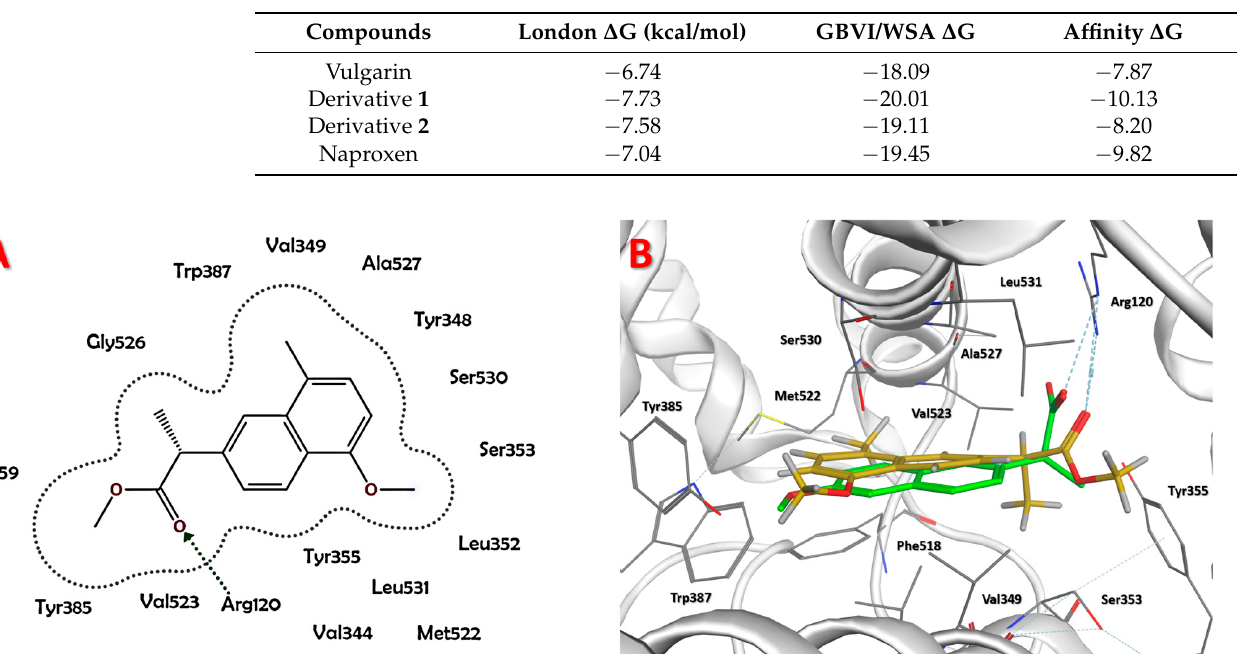
Table 2. Computed docking results of the investigated compounds compared to naproxen using pdb = 3NT1.